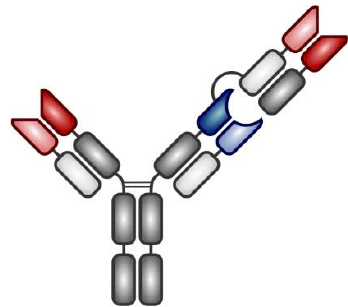
Figure 3. A simplified structure of glofitamab Legend: Blue and red colours represent variable fragments specific for CD3 and CD20, respectively.